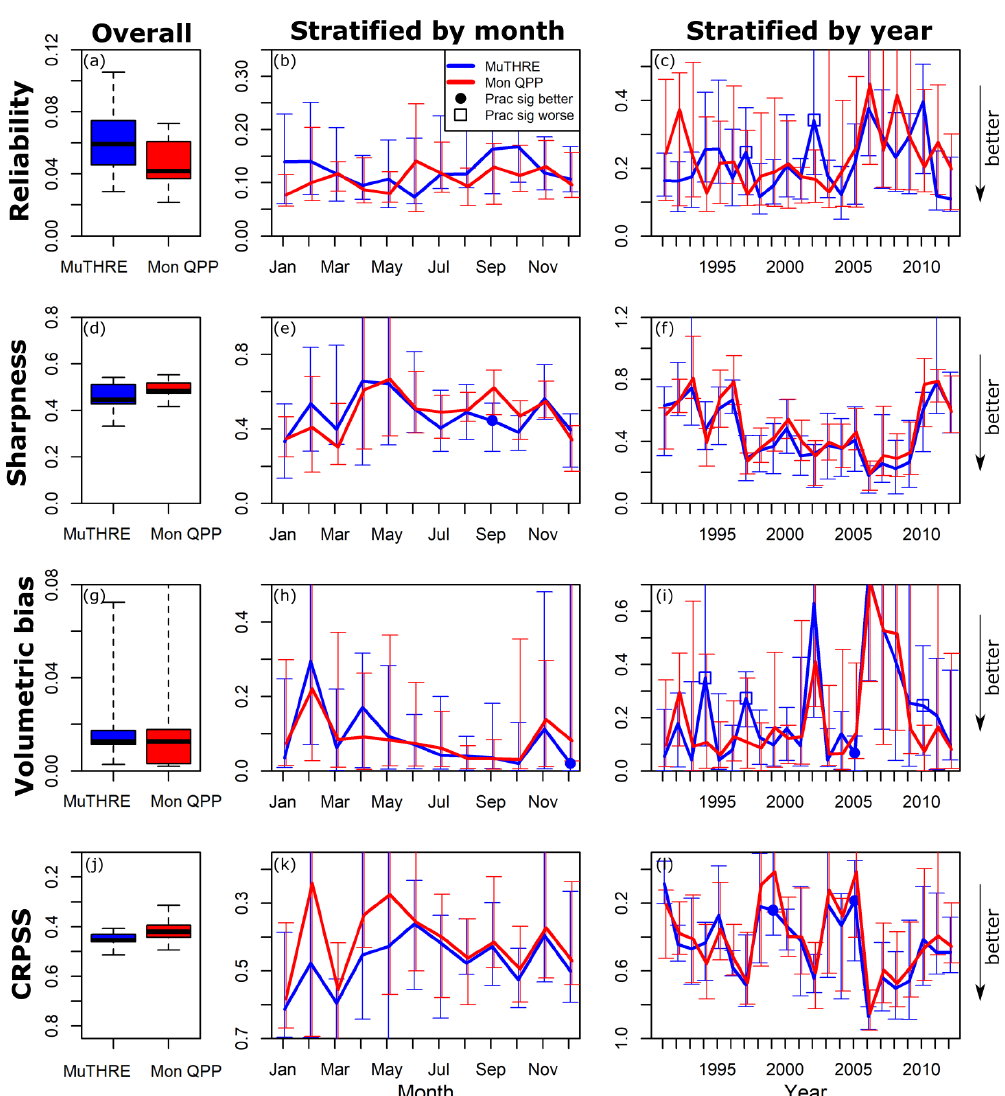
Figure 7. Overall performance (all months and years; a, d, g, j ), performance stratified by month (b, e, h, k) , and performance stratified by year (c, f, i, l) of monthly forecasts from the seamless MuTHRE and non-seamless monthly QPP models. Results are shown for reliability (a– c) , sharpness (d–f) , volumetric bias (g–i) , and CRPSS (j–l) . Box plots in the left column (a, d, g, j) show the distribution of metric values over the 11 catchments. In the other columns (b, c, e, f, h, i, k, l) , vertical bars indicate the full range of metric values across the catchments, the line indicates the median metric values, and circles/squares indicate that the MuTHRE model performs practically significantly better/worse than the monthly QPP